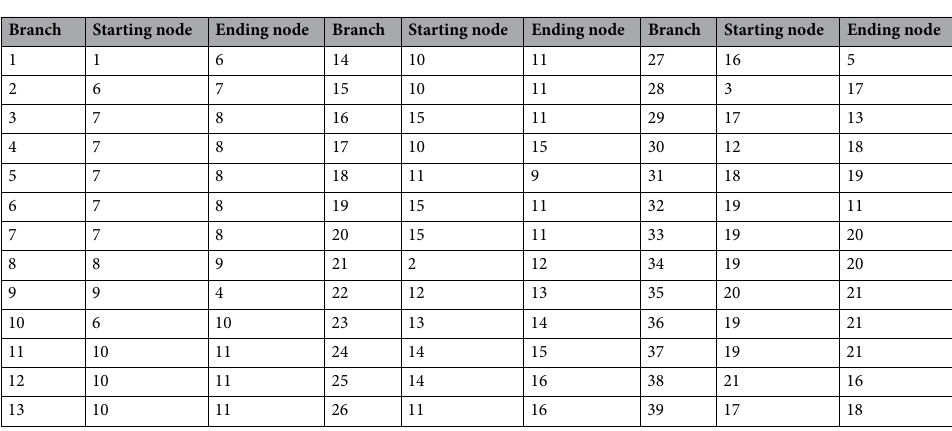
Table 2. Topological relation of ventilation network in Buertai Coal Mine.